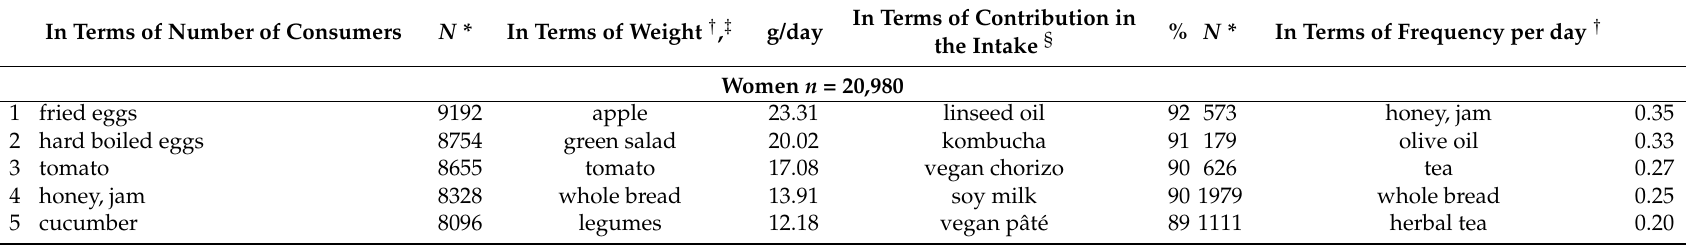
Table 4. Top 10 Organic Food items by gender, NutriNet-Santé Study, N =